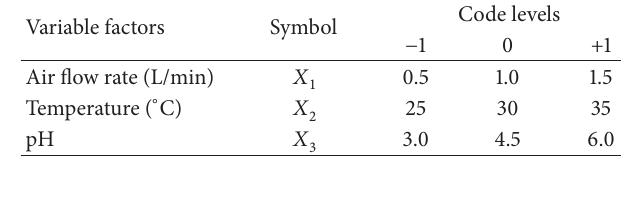
Table 1: Factors and levels of response surface methodology design.